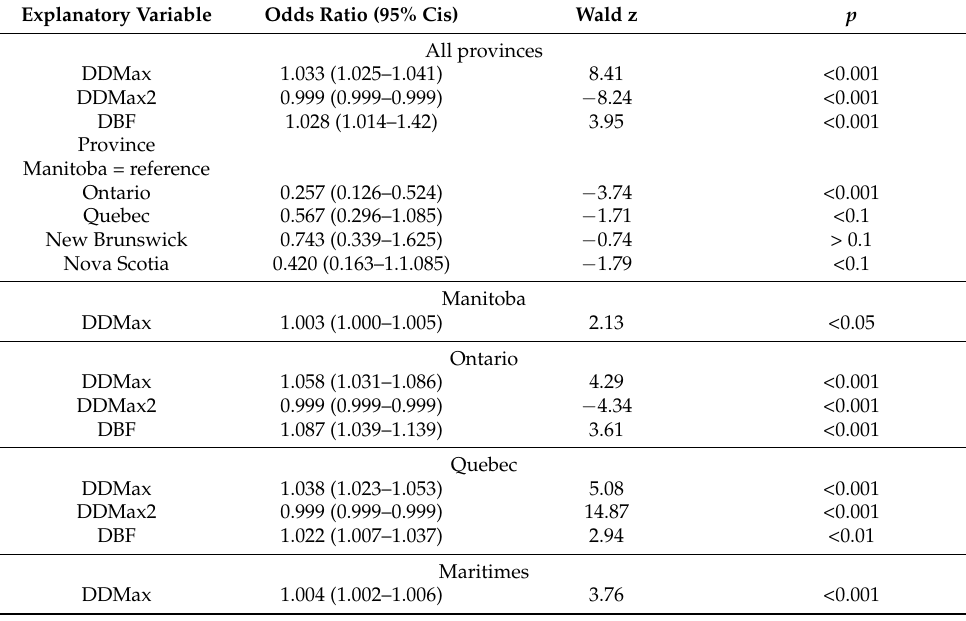
Table 2. Outcome of logistic regression models in which the outcome was presence/absence of Ixodes scapularis and temperature variables (maximum annual cumulative number of degree-days >0 ◦ C ([DDMax and a quadratic term DDMax2]), the proportion of land cover that was broadleaf forest (DBF) and province (in the model using data from all provinces) were explanatory variables.